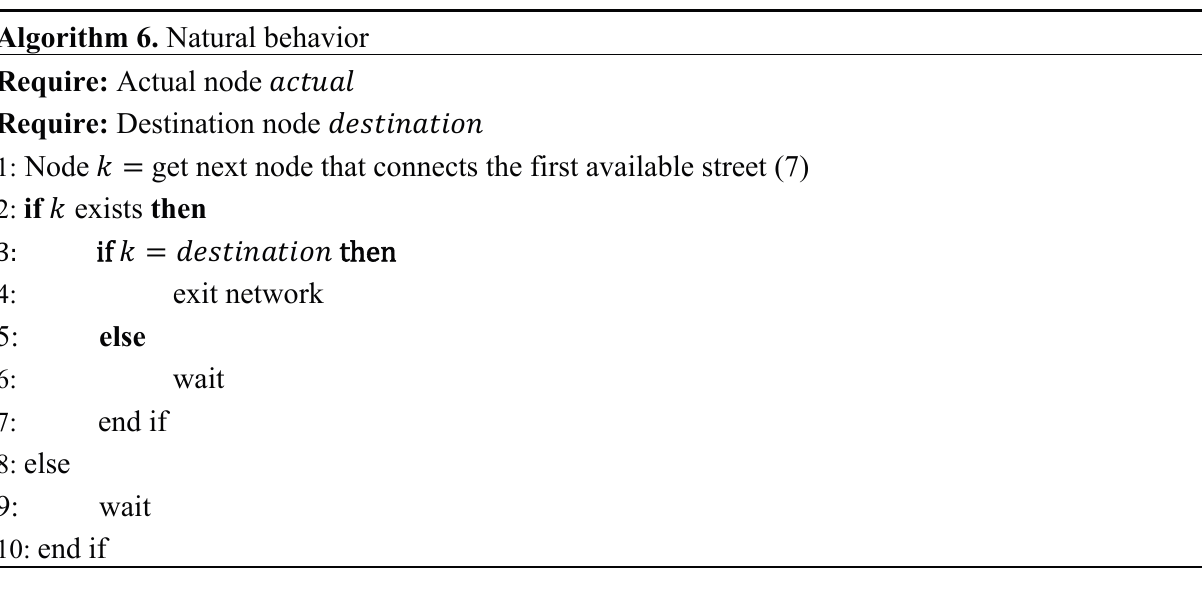
Algorithm 6. Natural behavior